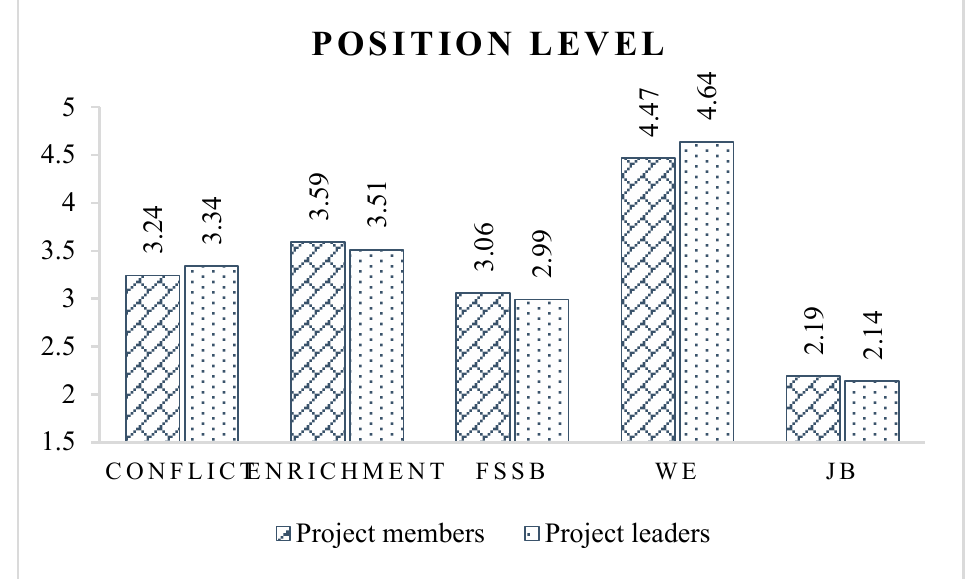
Figure 6. Latent variable scores of different position level groups.